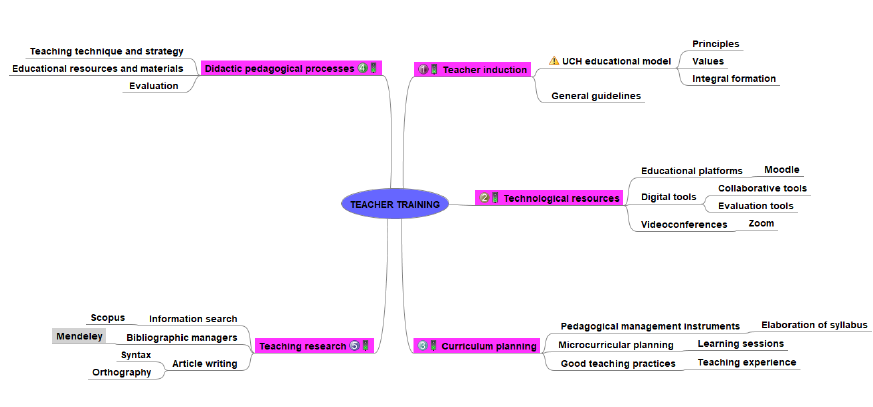
Fig. 13. Proposed